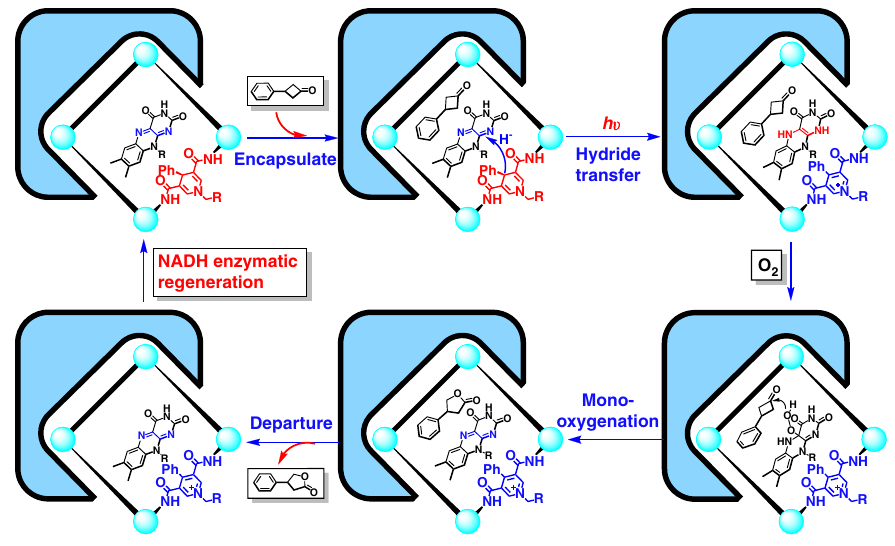
Fig. 6 Proposed mechanisms for the catalyst – enzyme coupled system in catalytic monooxygenation. Schematic of the supramolecular approach for the monooxygenation of cyclobutanones showing the enzymatic behavior within the con fi ned environment and in situ regeneration of the NADH model under redox enzymatic